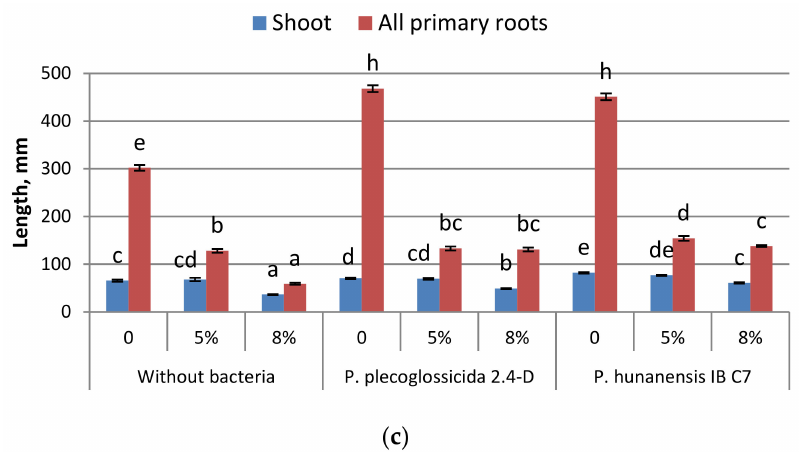
Figure 3. E ff ect of oil pollutants (50 and 80 g kg − 1 soil) and inoculation of seeds with strains of Pseudomonas bacteria on ( a ) germination, ( b ) seedling mass and ( c ) length of barley seedlings grown in soil and measured 7 days after seed soaking. Mean values ± SE are presented ( n = 30). Significantly di ff erent means of each parameter are marked with di ff erent letters ( p ≤ 0.05, t